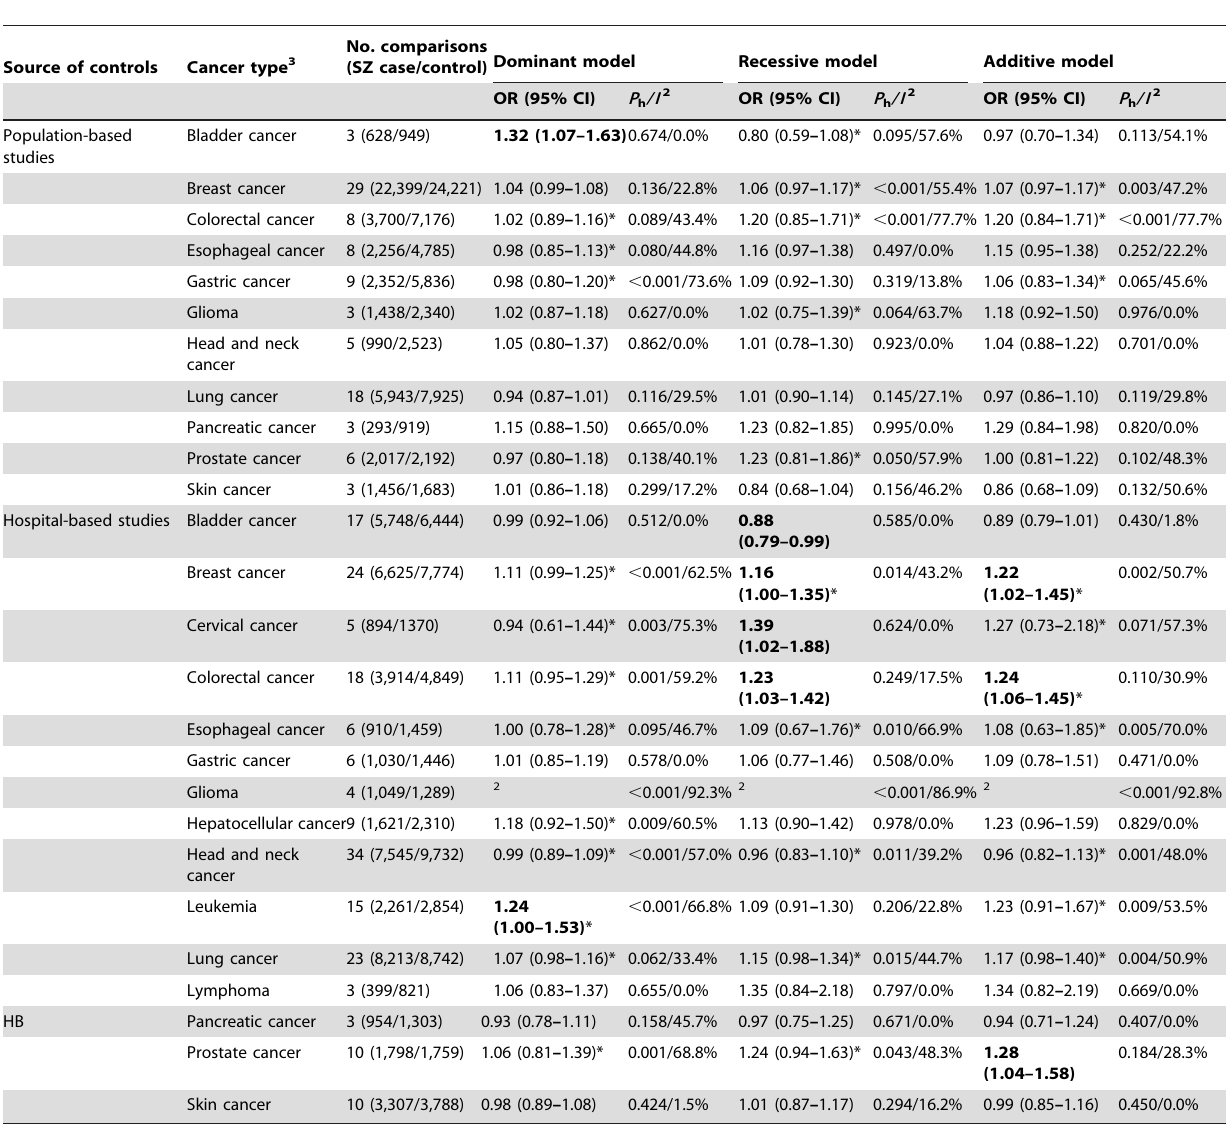
Table 3. Summary ORs (95% CI) and value of value of the heterogeneity of XRCC1 Arg399Gln polymorphism for studies according to source of controls and cancer type 1